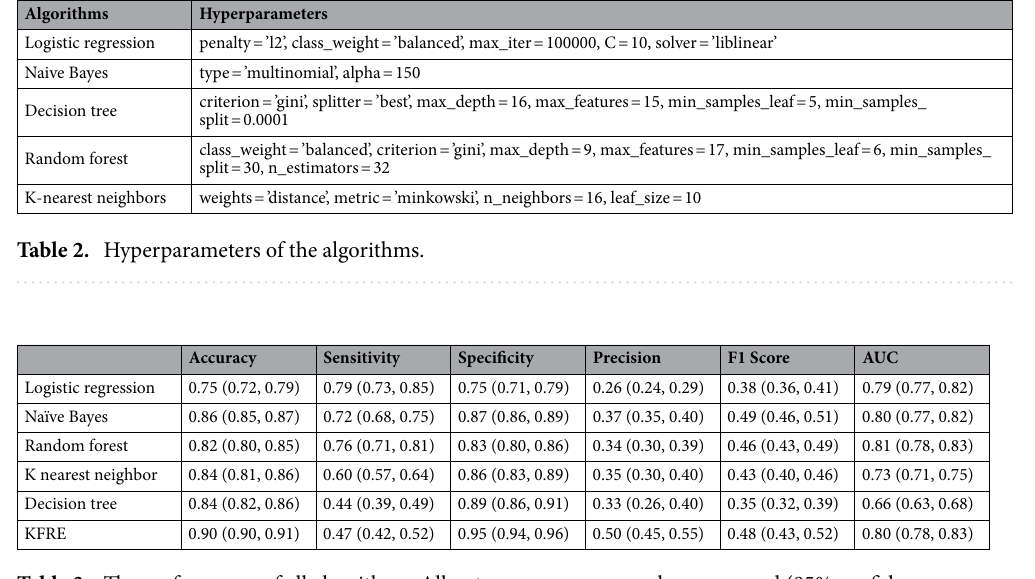
Table 3. The performance of all algorithms. All outcomes are expressed as mean and (95% confidence interval). KFRE kidney failure risk equation, AUC area under the curve.